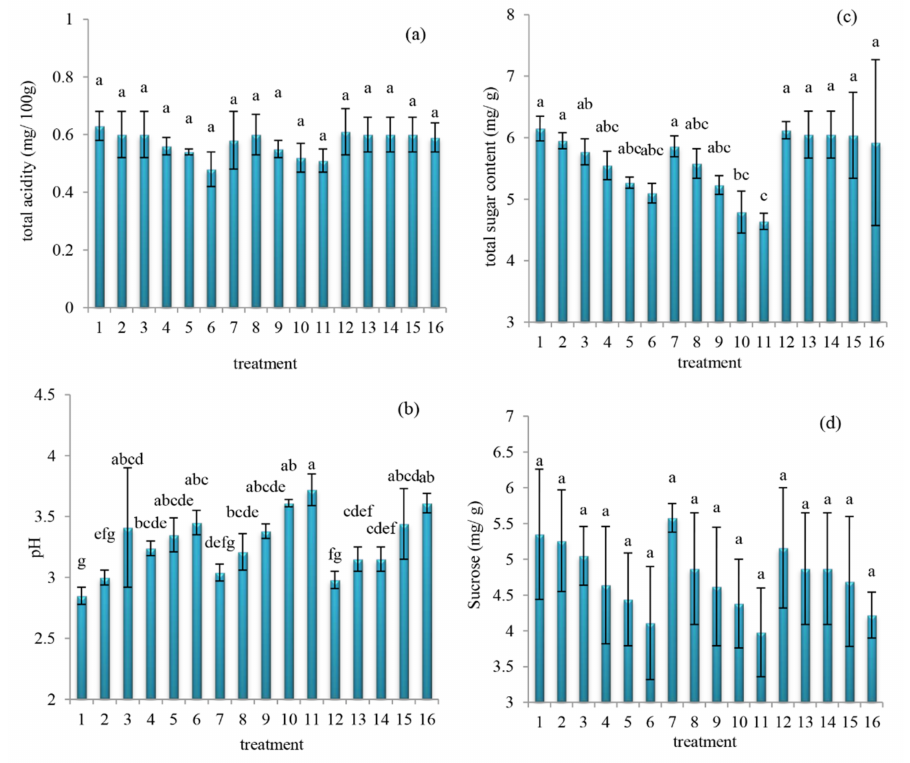
Figure 2. Changes in total acidity ( a ), pH ( b ), total sugar content ( c ), and sucrose ( d ) values of orange juice subject to different oleaster extracts ((1) control, (2) aqueous extract 5%, (3) aqueous extract 10%, (4) aqueous extract 15%, (5) aqueous extract 20%, (6) aqueous extract 25%, (7) alcoholic extract 5%, (8) alcoholic extract 10%, (9) alcoholic extract 15%, (10) alcoholic extract 20%, (11) alcoholic extract 25%, (12) hydro-alcoholic extract 5%, (13) hydro-alcoholic extract 10%, (14) hydro-alcoholic extract 15%, (15) hydro-alcoholic extract 20%, (16) hydro-alcoholic extract 25%). Different letters (a–g) indicate significant changes occurred at p <